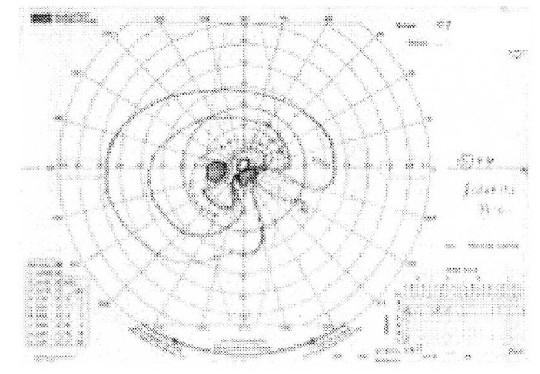
Figure 1 Visual field test on